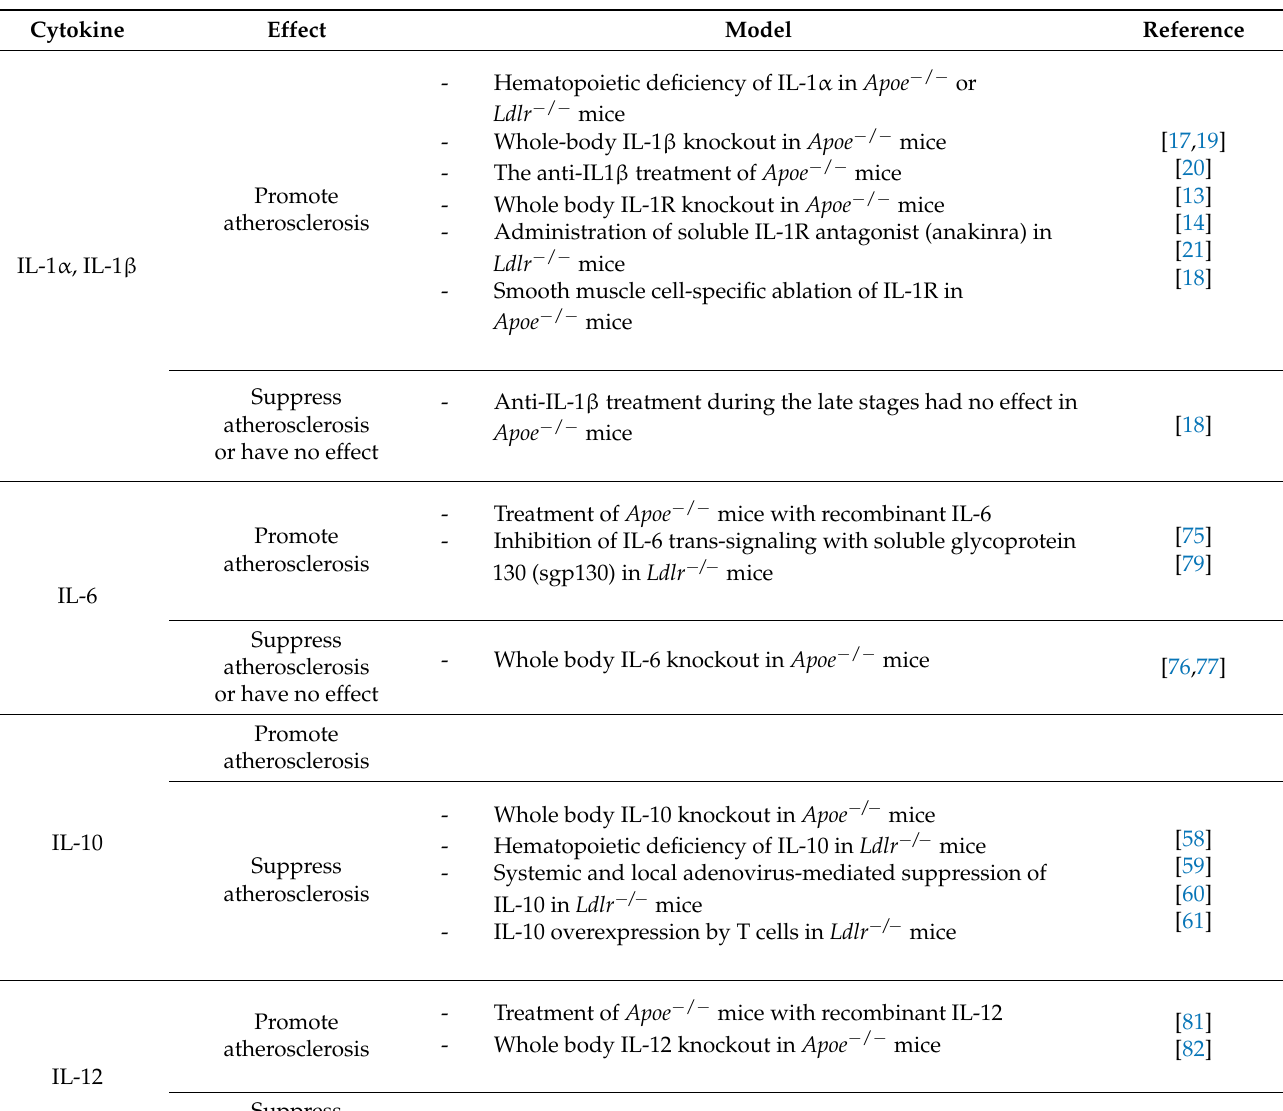
Table 1. The role of selected cytokines in